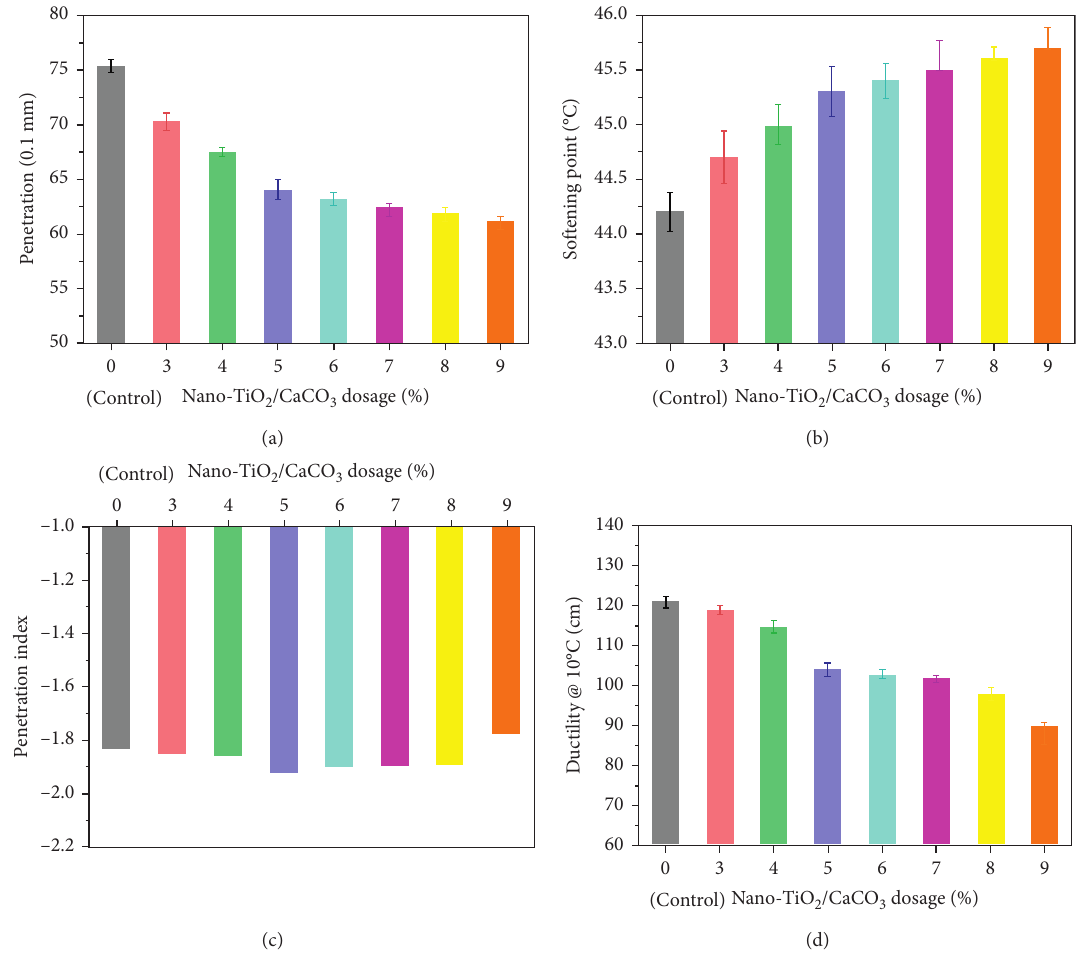
Figure 4: Conventional physical properties of bituminous samples with different nano-TiO 2 /CaCO 3 dosage. (a) Penetration, (b) SP, (c) PI, and (d) ductility. Table 3: The OD analysis of nano-TiO 2 /CaCO 3 -modified bitumen. Nano-TiO 2 /CaCO 3 dosage